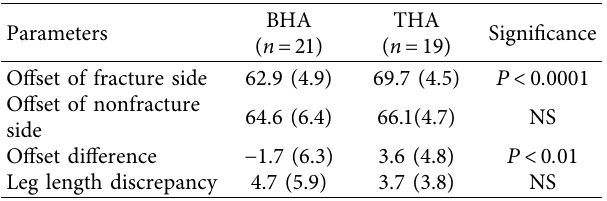
Figure 1: (a) Kaplan–Meier survival analysis showed no statistical difference between the THA group and the BHA group. (b) To confirm the diagnostic accuracy, ROC analysis was performed by evaluating the area under the curve (AUC). The AUC for identifying death was 0.904 (95% CI 0.811–0.998). Based on the ROC analysis, a cut-off value was the ASA score. The score of 3 and above was defined as the risk- high group, and the score of 2 and below was defined as the low-risk group to clarify the survival rate. (c) In performing chi-square analysis, there was no increased death in the THA group even in ASA 3 and above. Table 4: Radiographic